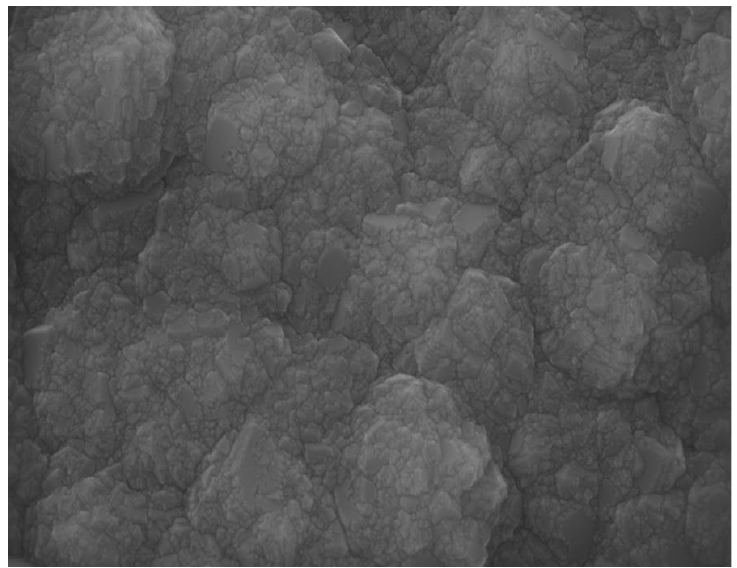
Figure 3. SEM image of a detonation nanodiamond powder, formed by aggregates of nanosized (<10 nm) polyhedral grains.